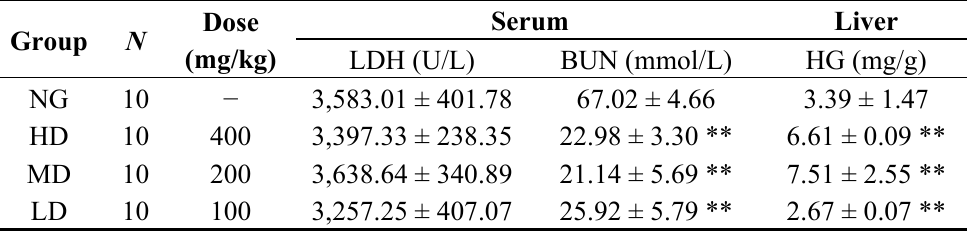
Table 1. Effects of E. ferox seed coat extract on LDH, BUN and HG levels in mice. Dose Group N